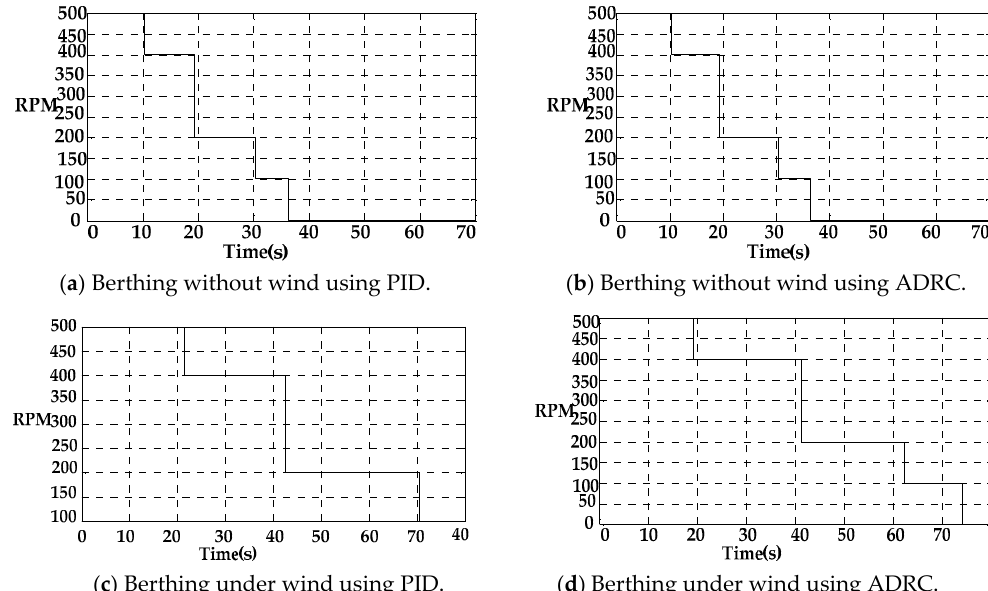
Figure 14 . Ship revolutions per minute (RPMs) in the simulation of ship automatic berthing.